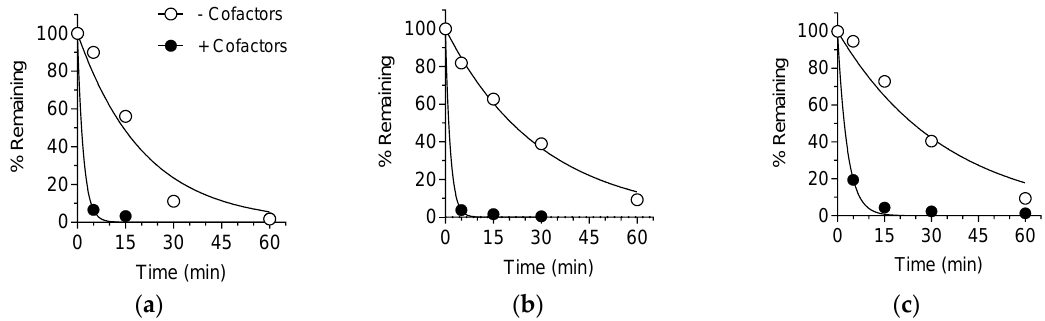
Figure 4. Metabolic stability of SP-8356 in ( a ) rat, ( b ) dog and ( c ) human liver S9 fractions. % Remaining was determined at selected time points following a 60 min incubation of SP-8356 (1 µ M) with liver S9 fractions (1 mg / mL), in the presence and absence of a cofactor mixture composed of NADPH (1 mM), UDPGA (1 mM), PAPS (1 mM), SAM (1 mM) and GSH (1 mM). Data are mean values of triplicate measurements. Table 5. Predicted hepatic metabolic stability of SP-8356 in rats, dogs and humans.